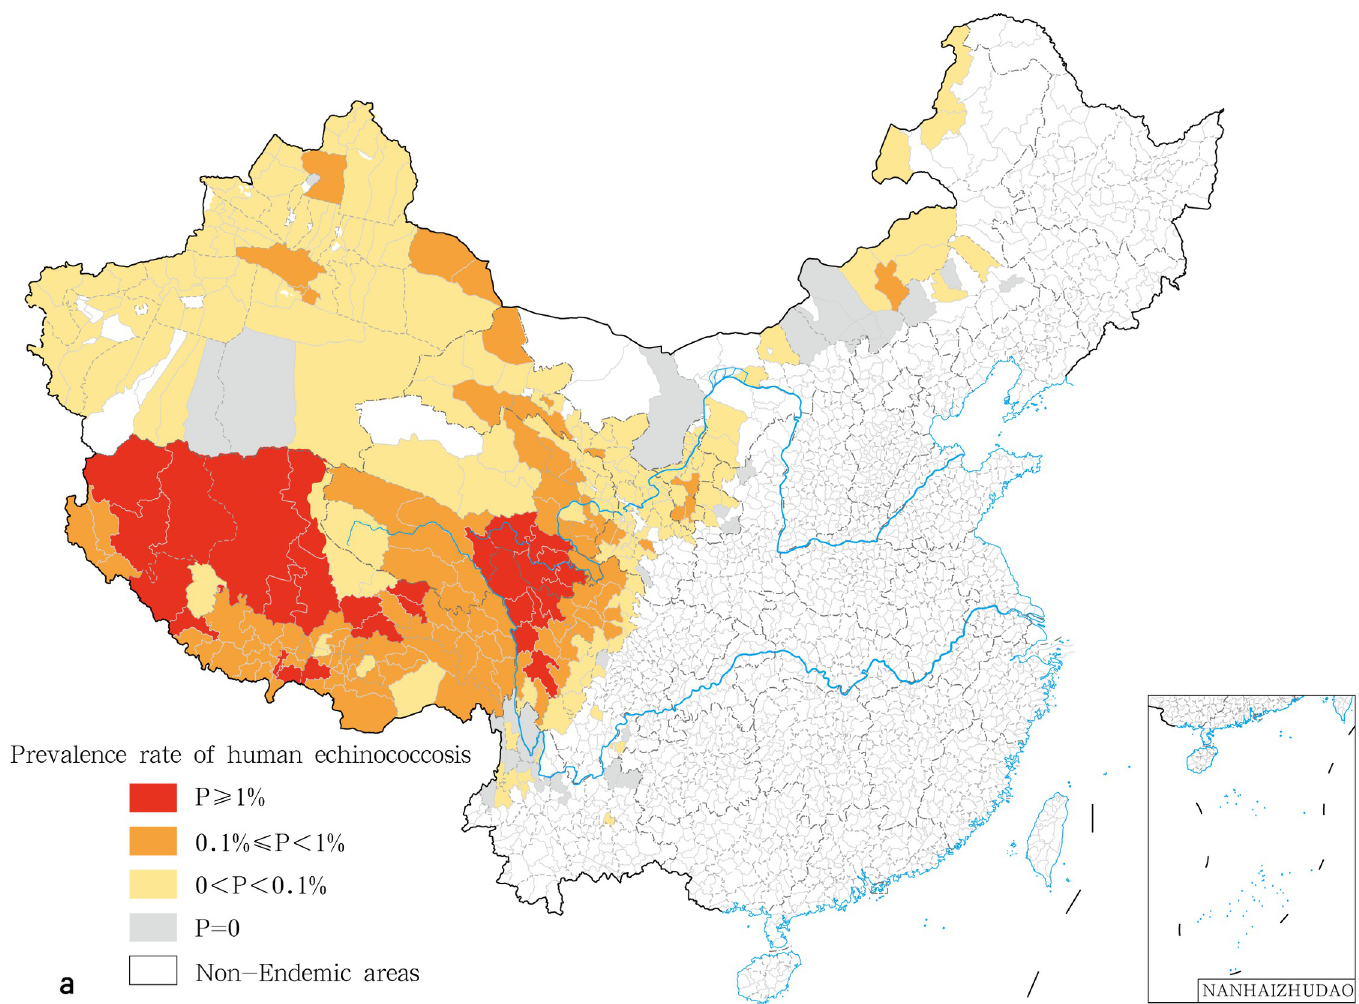
Fig 1. The spatial distribution of human echinococcosis in China in 2018. The base layer is from https://www.webmap.cn/mapDataAction.do?method=forw&resType= 5&storeId=2&storeName=%E5%9B%BD%E5%AE%B6%E5%9F%BA%E7%A1%80%E5%9C%B0%E7%90%86%E4%BF%A1%E6%81%AF%E4%B8%AD%E5%BF% 83&fileId=BA420C422A254198BAA5ABAB9CAAFBC1 with credit to National Catalogue Service For Geographic Information. independently. We found 21 class I counties for CE, mainly distributed in the central region of the Qinghai Tibet Plateau, including 14 counties in Tibet Autonomous Region, three counties in Sichuan (Shiqu, Seertar and Litang), and four counties in Qinghai (Tarlag, Jigzhi, Chindu and Gadee) (Fig 2). The counties with the highest incidence for CE were Gadee (301.1 / 10,000) in Qinghai, Zhongba county (255.1/ 10,000) and Baqeen (246.6/ 10,000) in Tibet, and Shiqu County (236.0 / 10,000) in Sichuan (Fig 2). Ninety eight Class II counties in seven prov- inces were recorded for CE (Fig 2). An additional 44 epidemic counties for CE displayed the conditions for transmission but with no local CE patients (Table 3 and Fig 2). With respect to AE, 6 class I counties were recorded, i.e. Shiqu (402.2 / 10,000) and Seertar (176.0 / 10,000) in Sichuan, Tarlag (291.3/ 10,000), Baima (227.9/ 10,000), Jigzhi (202.2/ 10,000) and Chido (161.0/10,000) in Qinghai (Fig 3). The Class II category comprised 10 counties (8.7%), includ- ing: Baiyu, Zamtang, Deegee and Garzee in Sichuan, Baqeen, Xainza and Bangoin in Tibet, Madoi, Gadee and Maqeen in Qinghai (Fig 3). Forty six counties from 6 provinces were